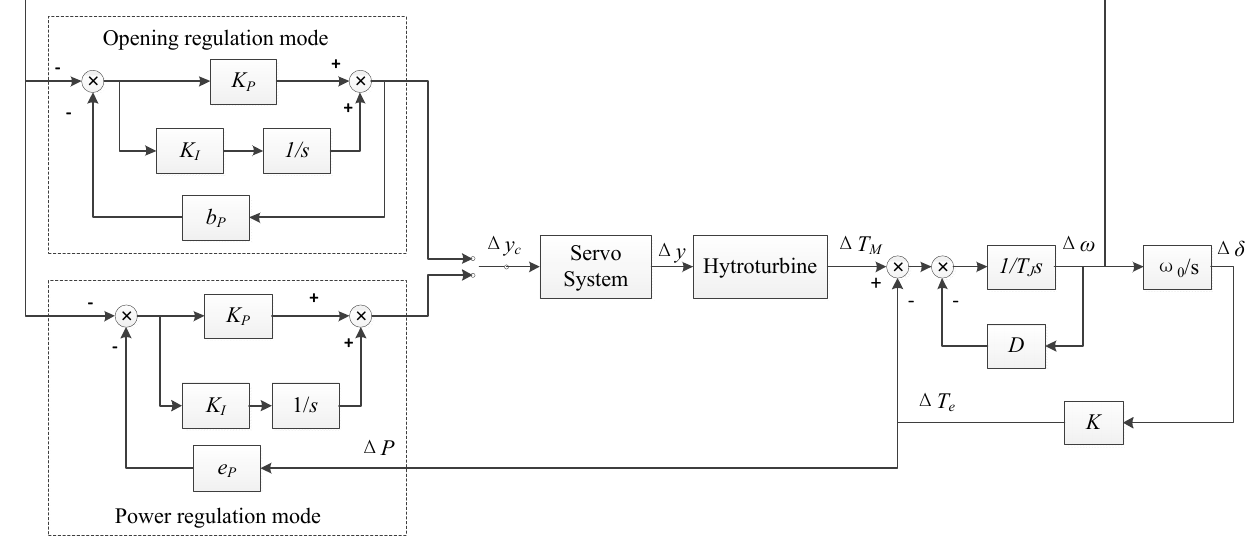
Figure 1. Structure of a hydropower unit.